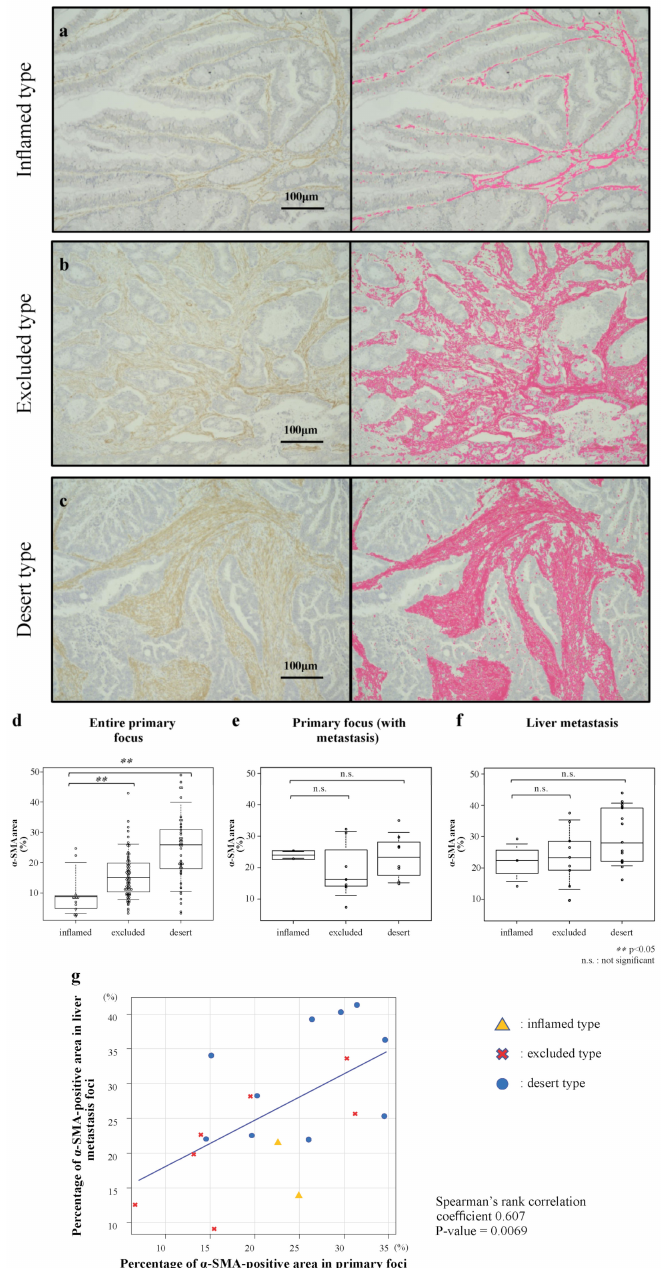
Figure 1. Analysis image of CAF-involved areas in human CRC for each phenotype. The left side shows immunostained images of α -SMA of human CRC primary foci, while the right side shows the images analyzed using BZ-X analysis software. The areas that were positive by immunostain- ing were automatically identified and shown in pink. The interstitial areas of ( a ) inflamed type, ( b ) excluded type, and ( c ) desert type are shown. The magnification of the micrographs is 200 × . The size bar represents 100 µ m. Percentage of CAFs in CRC primary foci and liver metastases determined based on phenotype. Quantified percentage of α -SMA-positive areas in ( d ) the entire CRC primary foci, ( e ) the primary foci in liver-metastasis cases, and ( f ) all liver metastases. ( g ) Scatterplot demonstrating the correlation between α -SMA-positive areas of primary foci and liver metastases in liver-metastasis